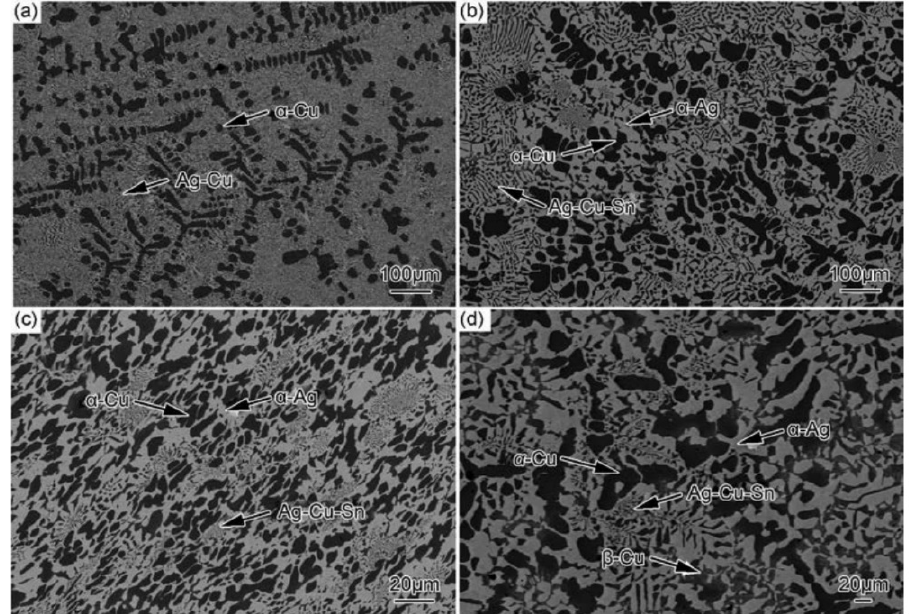
Figure 5. Microstructures of Ag60Cu-xSn filler metals containing ( a ) 0%, ( b ) 2%, ( c ) 4%, and ( d ) 8% Sn [16].